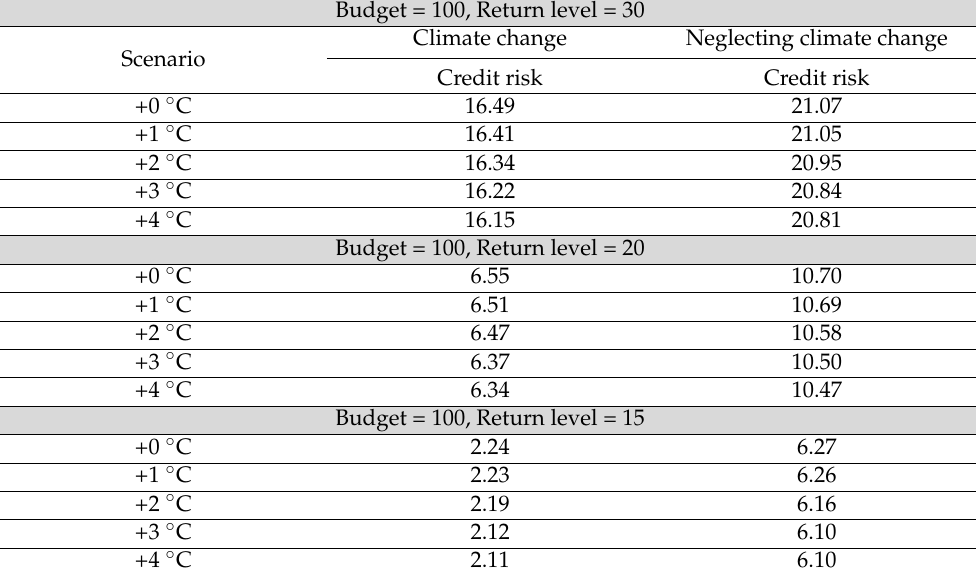
Table 2. Credit risk considering historical loan size (in 000s CAN dollars).